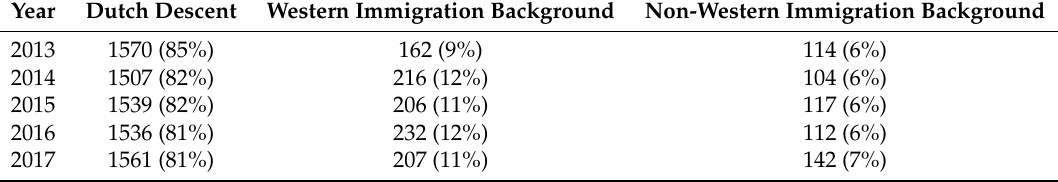
Table 7. Number of suicides among people of Dutch descent, people with a western migration background and people with a non-western immigration background among the entire population (percentage of total in year in brackets).